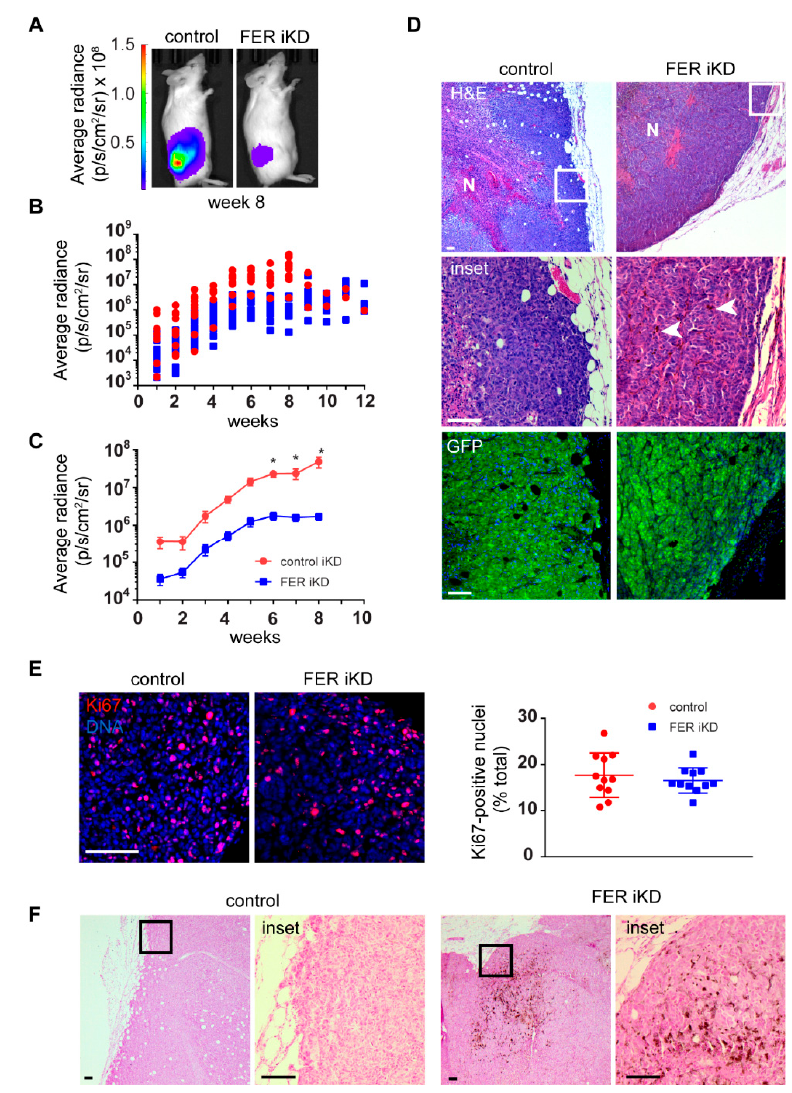
Figure 6. FER regulates melanoma primary tumor growth. ( A ) Bioluminescence imaging (BLI) of melanoma cells in vivo. Luciferase-expressing control and FER iKD melanoma cells were orthotopically transplanted in NSG immunodeficient mice, which were fed a dox-containing diet to induce shRNA expression. Melanoma cells were detected in live animals using BLI. ( B ) FER downregulation reduces growth in primary melanoma tumors. Following melanoma cell implantation, mice were imaged weekly and the signal detected from primary tumors in individual mice was quantified. ( C ) Mean radiance ± SEM ( n = 11) of control and FER iKD tumors 8 weeks post-transplantation. * represents p < 0.05 (Two-way repeated measures ANOVA, Sidak’s post hoc test). ( D ) Histological analysis of control and FER-deficient primary melanoma tumors. Tumor tissue sections were stained with hematoxilyn and eosin (H&E) and visualized with light microscopy. Necrotic areas (N) were present in both control and FER-deficient tumors. Tumor cells at the periphery were viable (insets) and pigmented tumor cell clusters (arrows) were detected in FER-deficient tumors. Immunofluorescence staining using an anti-GFP antibody was performed on adjacent tumor sections to confirm tumor cell viability (shRNA-expressing melanoma cells also express GFP). ( E ) Control and FER iKD tumors were processed for immunofluorescence microscopy with an anti-Ki67 antibody. DNA was visualized with Hoescht 33342. The percentage of Ki67-positive nuclei was determined ( n = 11). ( F ) Sections from control and FER iKD tumors were processed with Fontana-Masson staining and visualized with light microscopy to highlight melanin-producing melanoma cells. Bar = 100 µ